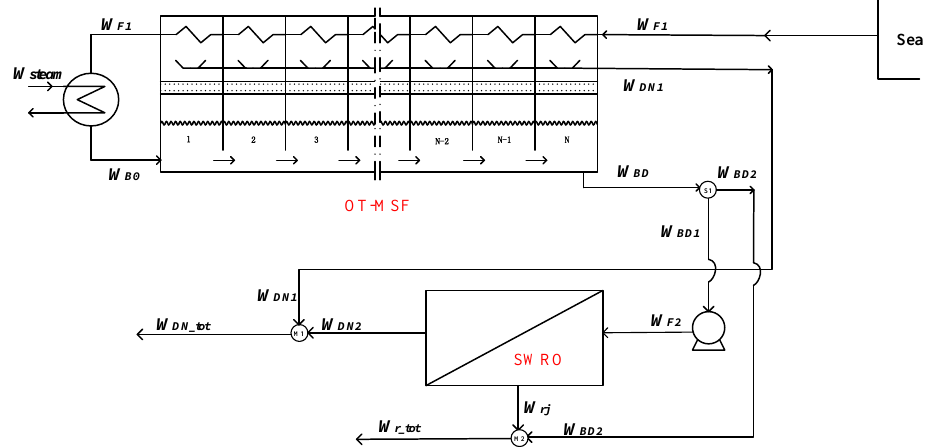
Figure 3. Option 3 — the last-stage flash water of the OT-MSF system as the feed water of the SWRO Figure 3. Option 3—the last-stage flash water of the OT-MSF system as the feed water of the system. SWRO system.